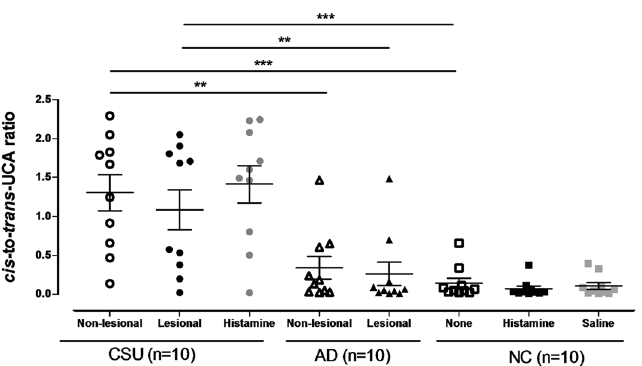
Figure 2. Ratio of cis- and trans- UCA measured in tape-stripped epidermal samples obtained from study subjects. Horizontal lines in the middle of the dot plots indicate mean values. AD, atopic dermatitis; CSU, chronic spontaneous urticaria; Histamine, histamine-induced wheals; NC, normal control. * , ** , *** P < 0.05, 0.01, 0.001, obtained by one-way ANOVA with Bonferroni’s post-hoc